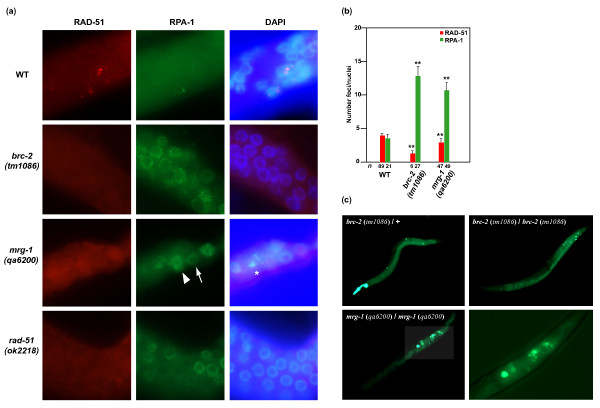
Phenotypic study of Caenorhabditis elegans brc-2 and mrg-1 mutants. (a) Representative images of meiotic cells at the distal part, near the gonad bend. RAD-51 foci are bright and nuclear in wild-type (WT) animals whereas RAD-51 foci appear less intense and weakly diffuse in the cytoplasm, reduced but often dispersed and intense in the nuclei, or absent in brc-2, mrg-1 and rad-51 mutants, respectively. There are more RPA-1 nuclear foci in each of the three mutants than in WT animals. 4,6-Diamidino-2-phenylindole (DAPI) panels are merged with the red channel (for WT and brc-2 mutant) and with the green channel (for rad-51 mutant). *Abnormal chromosomal compaction. (b) Quantitation of RAD-51 and RPA-1 foci per nuclei in several germ cell lines of WT animals and brc-2 and mrg-1 mutant animals. Number of cells scored (n) and standard deviation of the mean indicated. **Significant differences relative to WT (Mann-Whitney U test, P < 0.001). (c) SYTO-12 staining in synchronized adult worms. Left top panel: an animal heterozygous for the brc-2 mutation (according to green fluorescent protein expression at the pharynx) shows WT SYTO-12 staining (that is, one to two labeled cells at the gonad bend). Right top and left bottom panels: an increase in SYTO-12-positive cells in the germline of brc-2 and mrg-1 mutants, respectively. Right bottom panel: magnification of the highlighted area in the left panel.